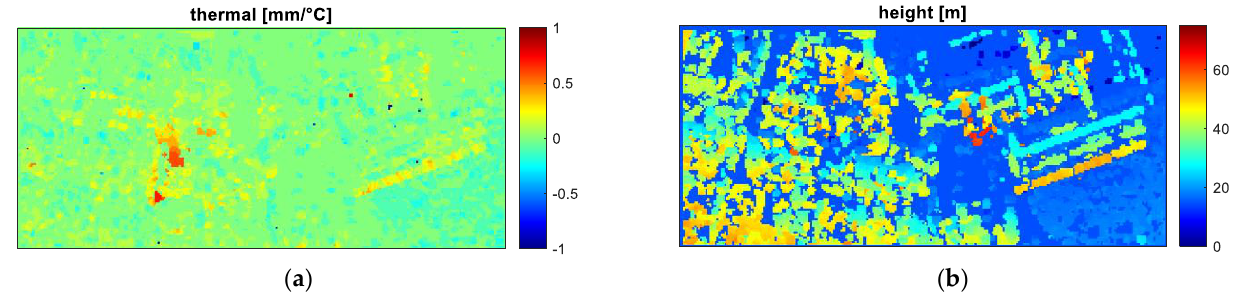
Figure 4. Galleria Umberto I test site: ( a ) LiDAR height map; ( b ) Single-look GLRT height map; ( c ) MGLRT height map obtained using a 3 × 3 patch; ( d ) MGLRT height map obtained using a 5 × 5 patch.